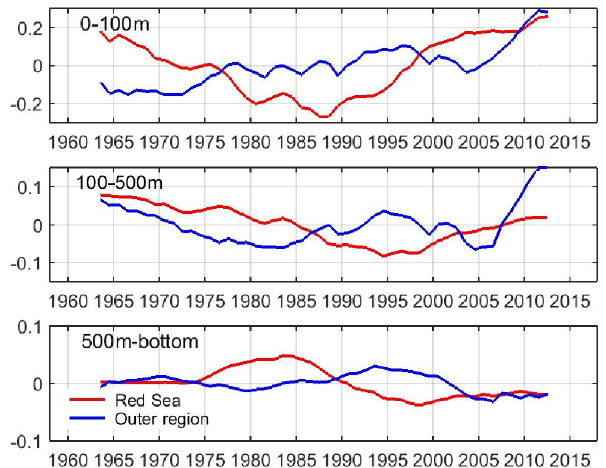
Figure 19. Low-pass-filtered temperature time series (in ◦ C) at dif- ferent layers in the Red Sea and the Outer zone. A 10-year moving average was applied to the monthly time series. Note the different vertical axis in each panel.